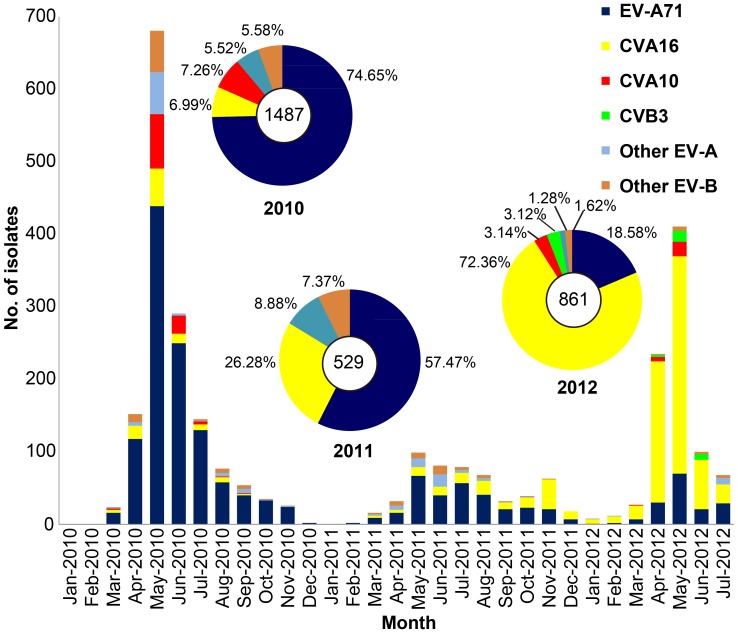
Monthly distribution and constituent ratio of EV serotypes associated with patients with HFMD in Shijiazhuang City, China, during 2010–2012.